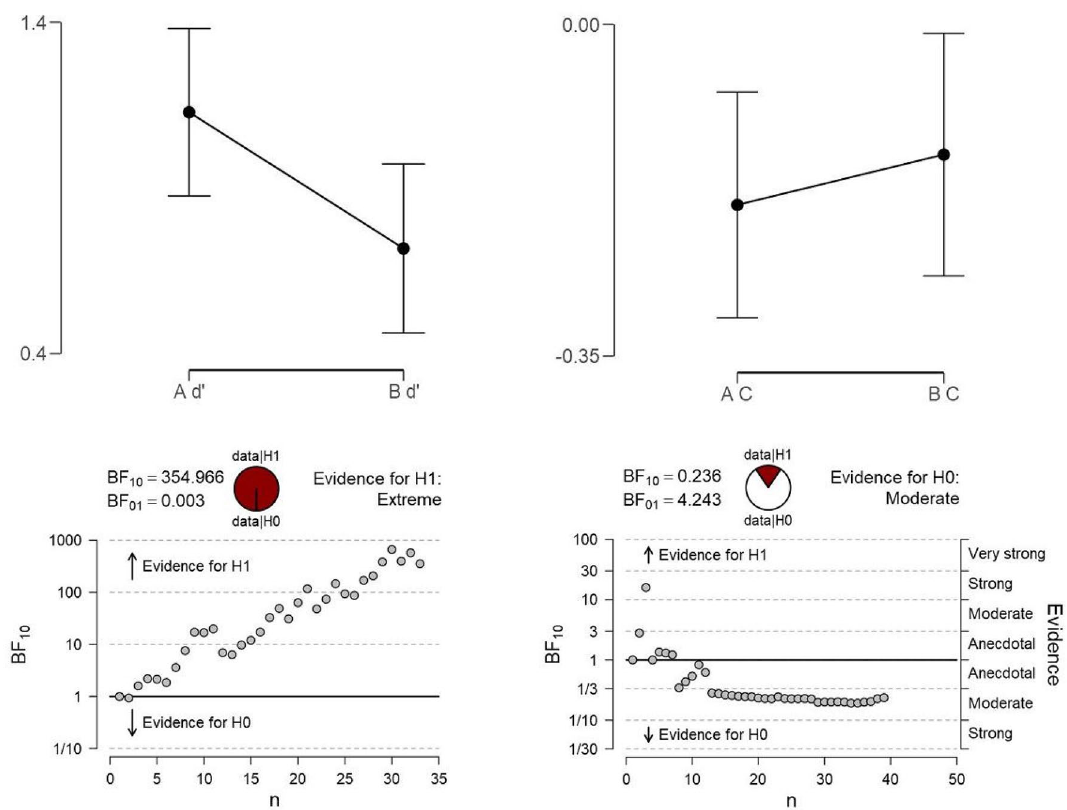
Figure 5. Experiment 2. Top: Line graphs (with confidence intervals) of the average d ′ scores in block A and V (left) and of C in block A and B (right). Bottom: Bayesian t-test sequential analyses of sensitivity (d ′ ) between Block A and B (i.e., original videos in A versus incongruent videos in